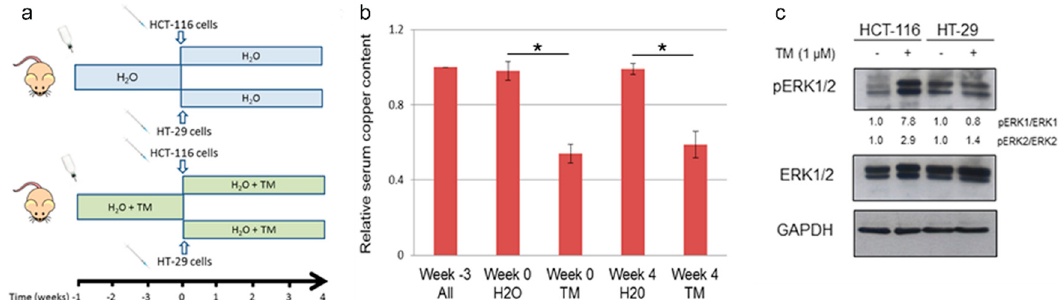
Figure 5. Copper chelation results in reduction of serum copper content and in modulation of MAPK signaling in an in vivo human colon carcinoma xenograft model. ( a ) Schematic representation of animal study: animals were randomly assigned to two group (8 mice each), one receiving drinking water and the second drinking water supplemented with TM. After 3 weeks each group was divided in two subgroups: one receiving subcutaneous administration of HCT-116-luc and the second HT-29-luc. Tetrathiomolybdate administration effectively reduced serum copper content ( b ) and modulated ERK1/2 phosphorylation in a xenograft model of BRAF V600E -derived colorectal tumors, as assessed by immunoblot analysis ( c ). * ( p < 0.05).